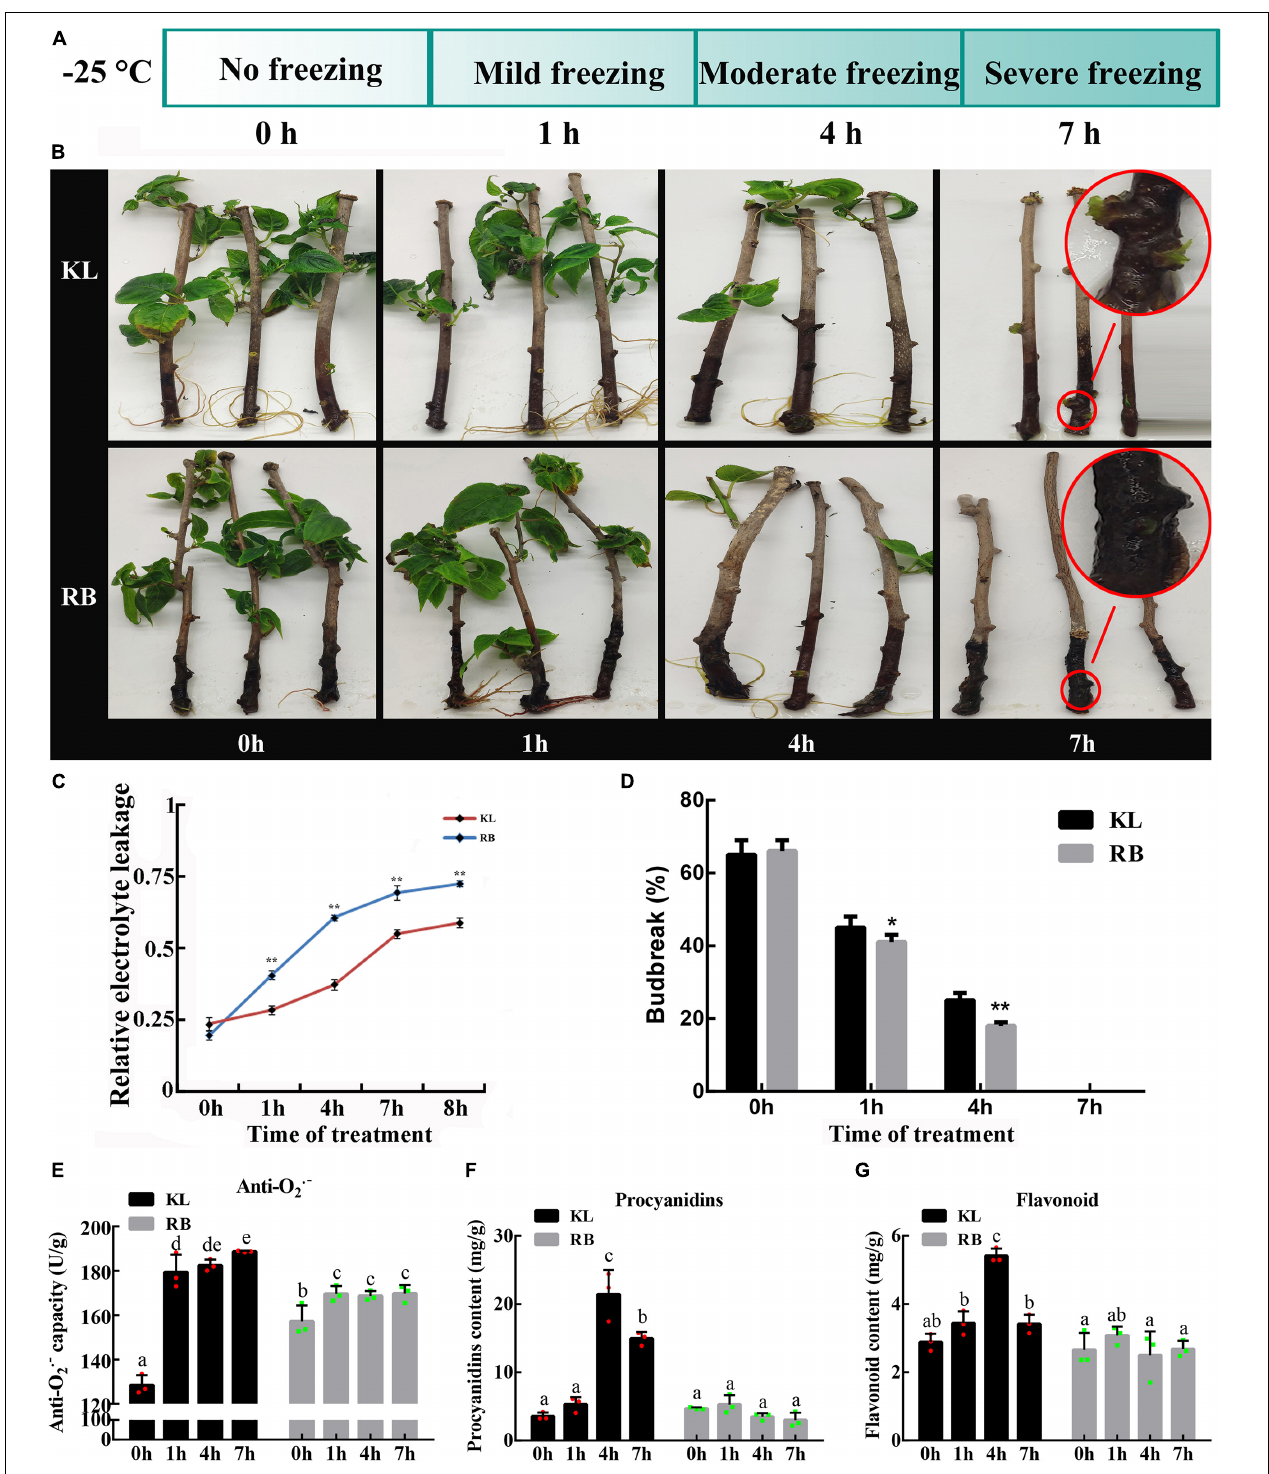
FIGURE 2 | Different REL (relative electrolyte leakage) and VB (vegetative bud) between the KL and RB genotypes under the − 25 ◦ C treatment. (A) Metabolomic and transcriptomic analysis of both genotypes were performed at four time points: 0 h, 1 h, 4 h, 7 h. (B) Representative images of KL and RB at 0 h, 1 h, 4 h, 7 h. (C) The REL at different treatment time points under − 25 ◦ C. (D) VB rates after the − 25 ◦ C treatment, given as the mean of three independent replicate experiments in both genotypes. (E) The anti − O 2 . − capacity at different treatment. (F) The content of procyanidins at different treatment. (G) The content of flavonoid under − 25 ◦ C.